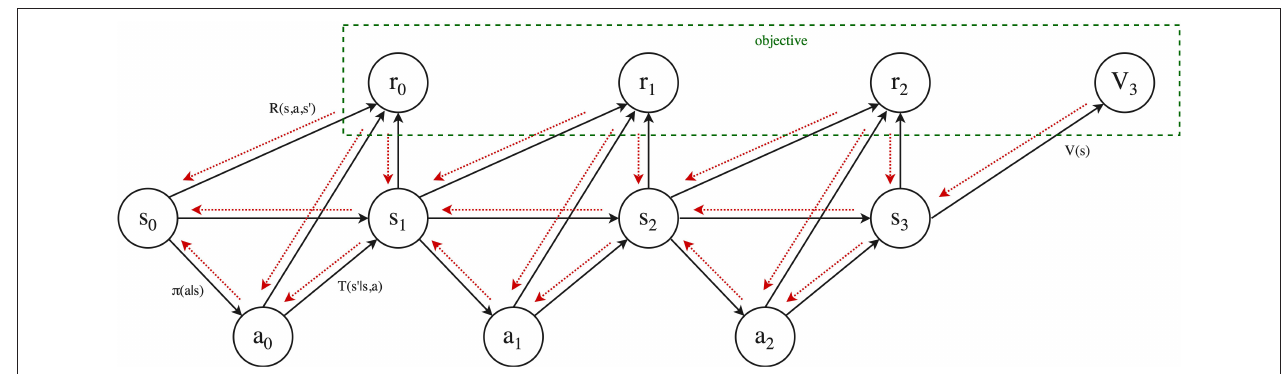
FIGURE 8 | Illustration of gradient-based planning. When we have access to a differentiable transition function T ( s ′ | s , a ) and differentiable reward function R ( s , a , s ′ ), and we also specify a differentiable policy π θ ( a | s ), then a single trial generates a fully differentiable computational graph. The figure shows an example graph for a trial of depth 3. The black arrows show the forward passes through the policy, dynamics function and rewards function. In the example, we also bootstrap from a differentiable (learned) value function, but this can also be omitted. We may then update the policy parameters by directly differentiating the cumulative reward (objective, green box) with respect to the policy parameters, effectively summing the gradients over all backwards path indicated by the red dotted